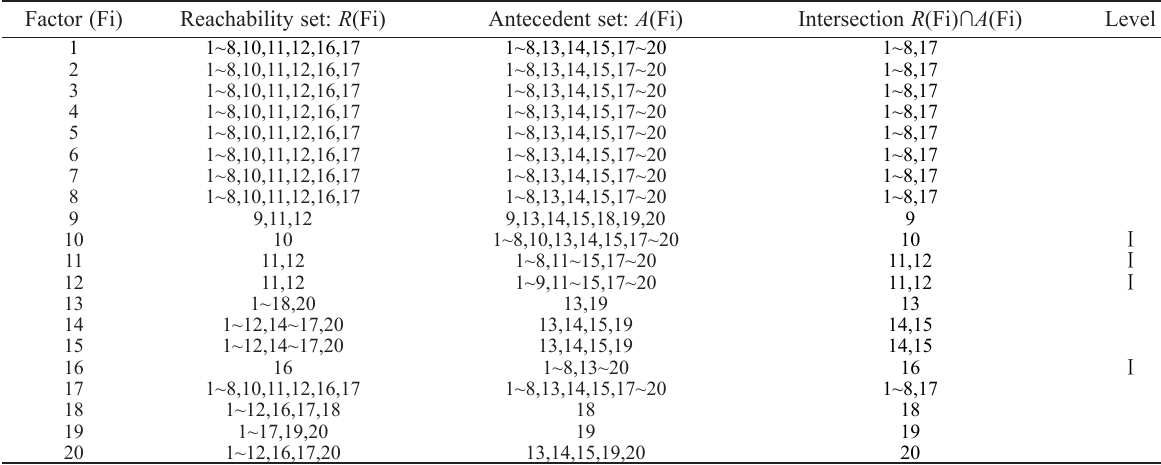
Table 6. First iteration of Reachability Matrix Factor (Fi)